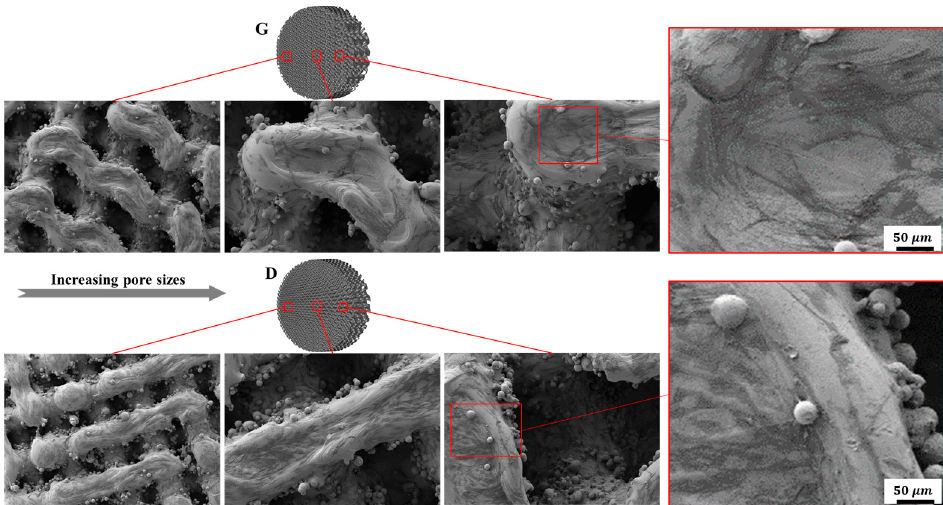
Figure 14. Representative SEM images of osteoblasts adhering to Gyroid and Diamond scaffolds with consecutive gradient in cell-sizes ranging from 0.6 to 2 mm.